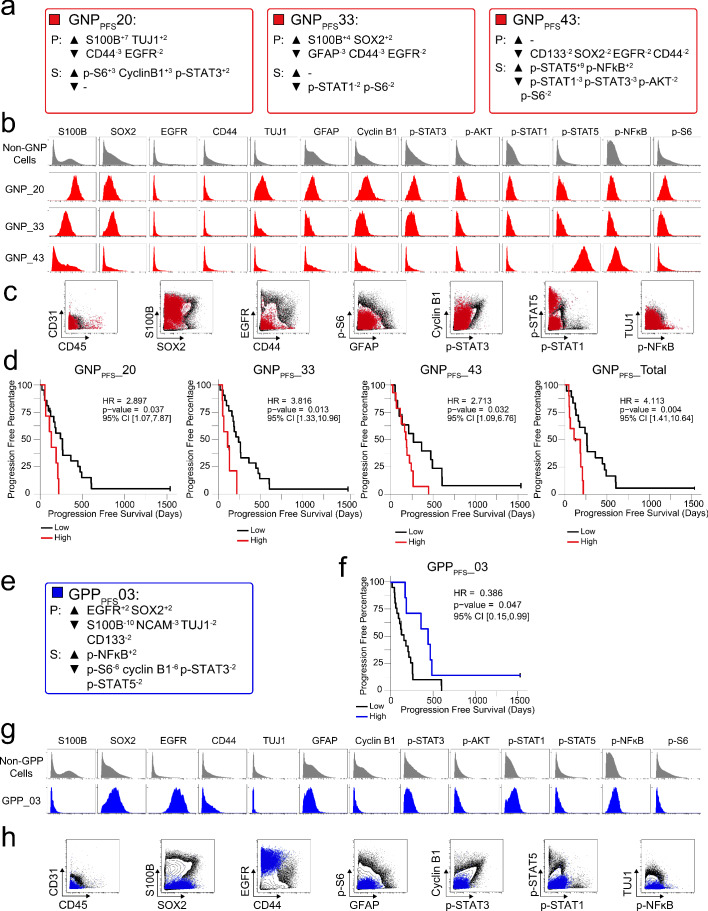
RAPID identified four populations associated with time to disease progression.(a) Enrichment of identity proteins (P) and phosphorylated signaling effectors (S) of GNP cell subsets revealed by analysis of disease progression (GNPPFS) was quantified using MEM. (b) Histogram plots of each GNPPFS cell subset (red) and all other glioblastoma cells (gray) illustrate the expression of proteins and phosphorylated signaling effectors. (c) Combined GNPPFS cell subsets (red circles) were mapped over biaxial plots of all other tumor cells (black contours). (d) For each subset, PFS was compared between patients with high vs low cell abundance (see Materials and methods). (e) Enrichment of identity proteins (P) and phosphorylated signaling effectors (S) of the GPPPFS cell subset was quantified using MEM. (f) PFS was compared between patients with high vs low GPPPFS cell abundance (g) Histogram plots of the GPPPFS cell subset (blue) and all other glioblastoma cells (gray) illustrate the expression of proteins and phosphorylated signaling effectors. (h) The GPPPFS cell subset (blue circles) was mapped over biaxial plots of all other tumor cells (black contours).